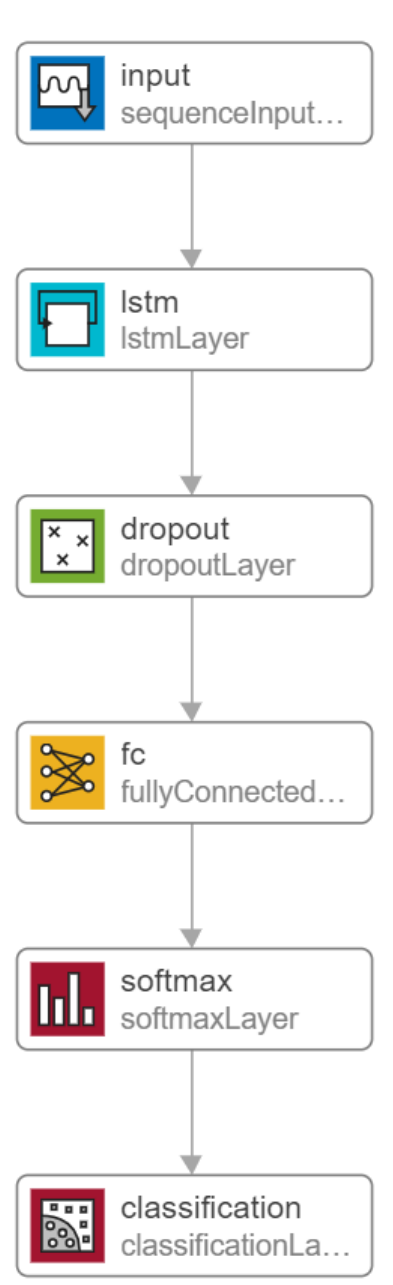
Figure 5. Overview of Long-Short Term Memory (LSTM) Matlab architecture. The input represents a 40 sample segment of a 3 dimensional (triaxial) input of raw accelerometer